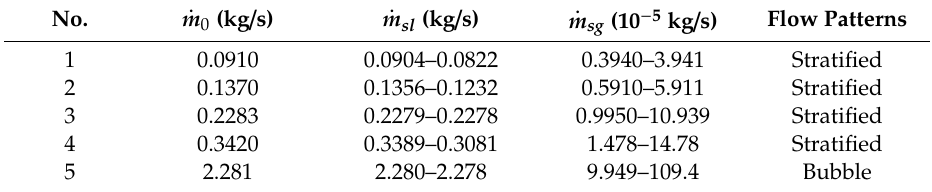
Table 2. Inlet setting ranges of gas-liquid two-phase flow simulation.